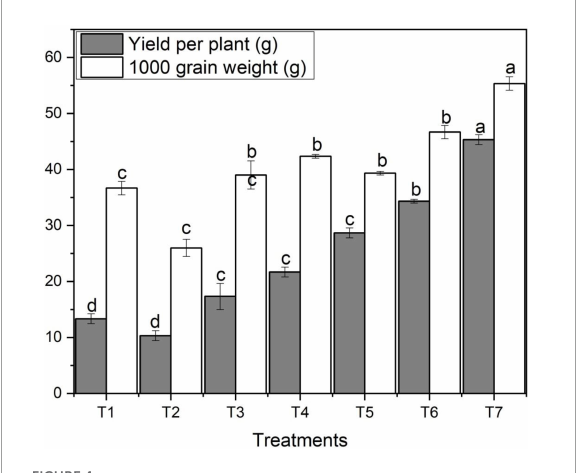
FIGURE3 Effects of different treatments on chlorophyll contents under salinity stress. Different letters indicate a significant difference by Duncan’s multiple range tests at p < 0.05. Values are means ± SE ( n = 3). T 1 : without fertilizer application (control), T 2 : N:P:K (150:100:60 kg ha - 1 ) + Salinity (10 dS m - 1 ), T 3 : N:P:K